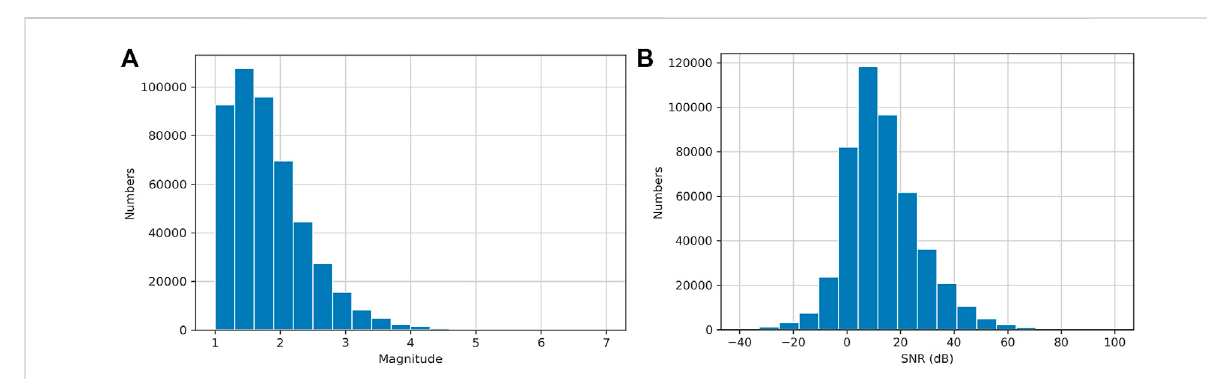
FIGURE 2 Magnitude distribution of the training set (A) , signal-to-noise ratio distribution of the training set (B)